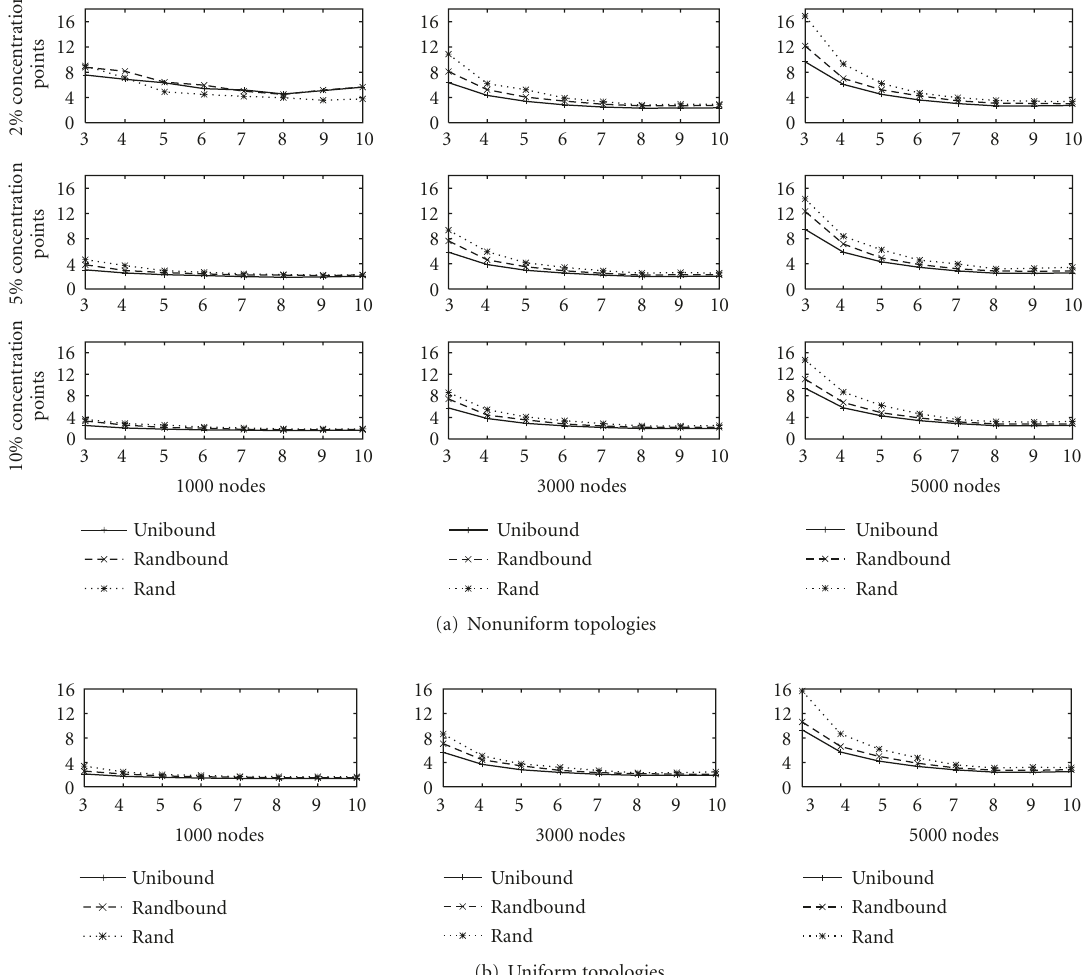
Figure 9: Average number of nodes per zone ( y axis), as a function of number of landmarks ( x